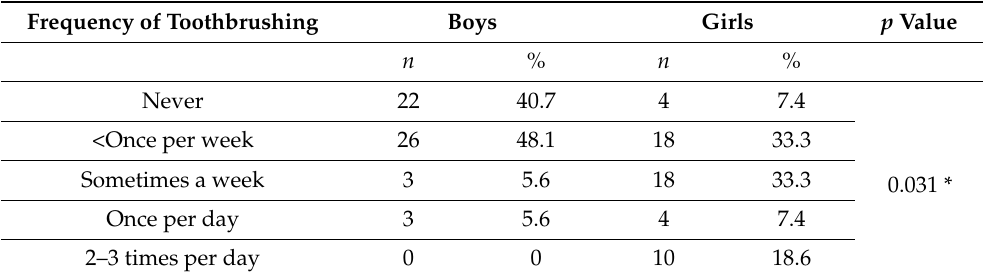
Table 5. Frequency of brushing by sex in the age group of 10–13